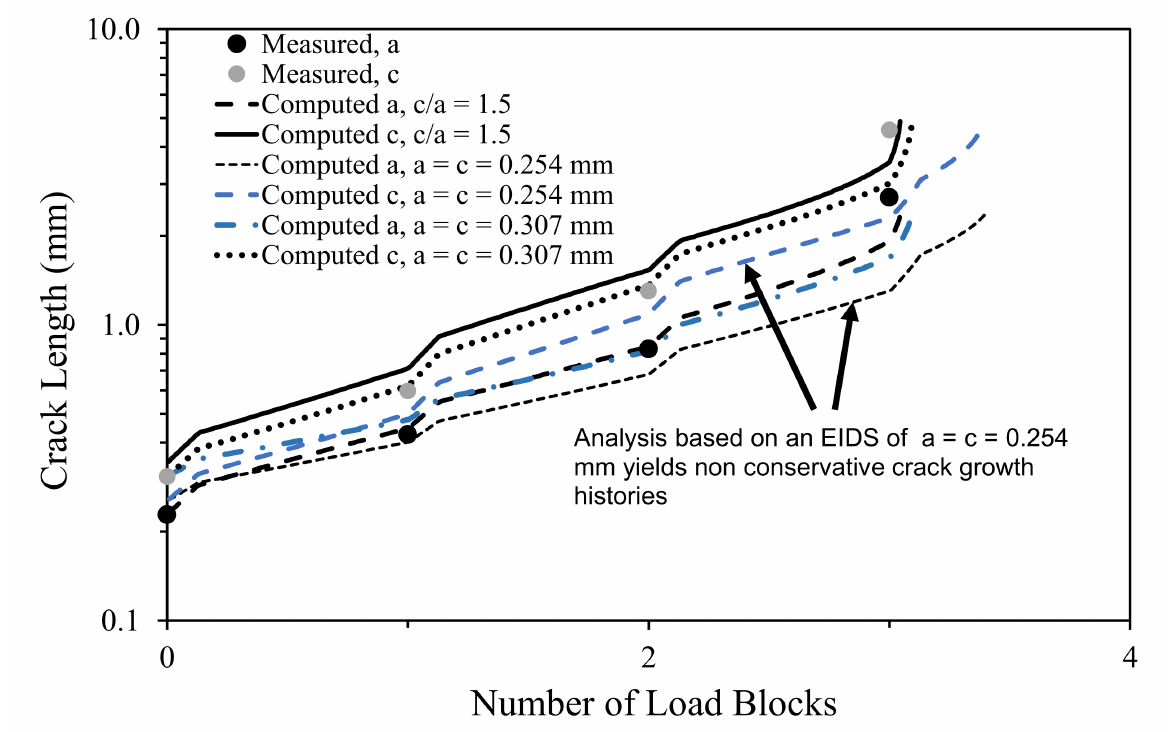
Figure 17. Comparison between measured and computed crack growth histories using an EIDS with c / a = 1.0 and